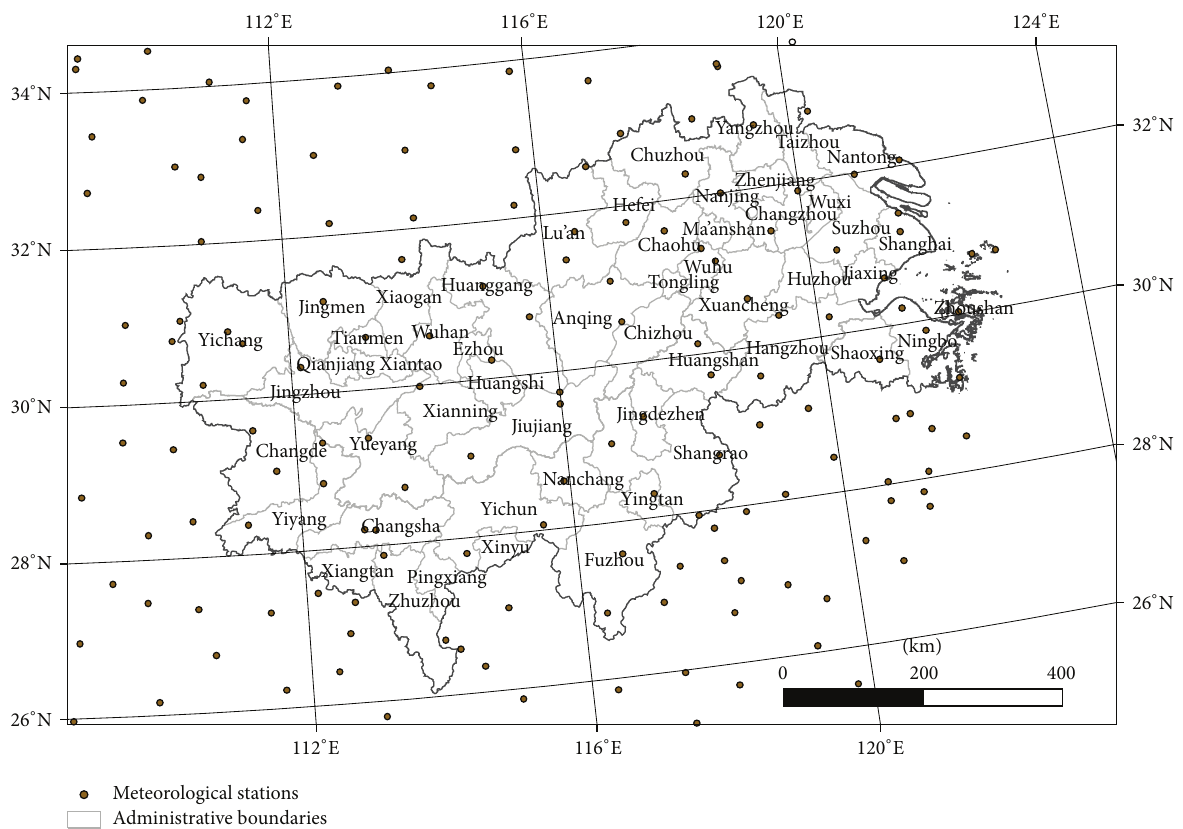
Figure 2: Distribution of the meteorological stations used for interpolation within and around the study area. Table 2: Land-use conversion from non-built-up to built-up area, 1988–2008 (area unit: ten thousand hectares). Period/land-use